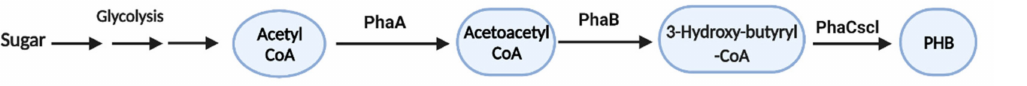
Figure 3. The PHB Biosynthesis Pathway C. necator H16. Condensation of 2 acetyl-CoA molecules by B-ketothiolase (PhaA), forming acetoacetyl-CoA, which is reduced by acetoacetyl-CoA reductase (PhaB). The last stage is polymerization by PHA synthase